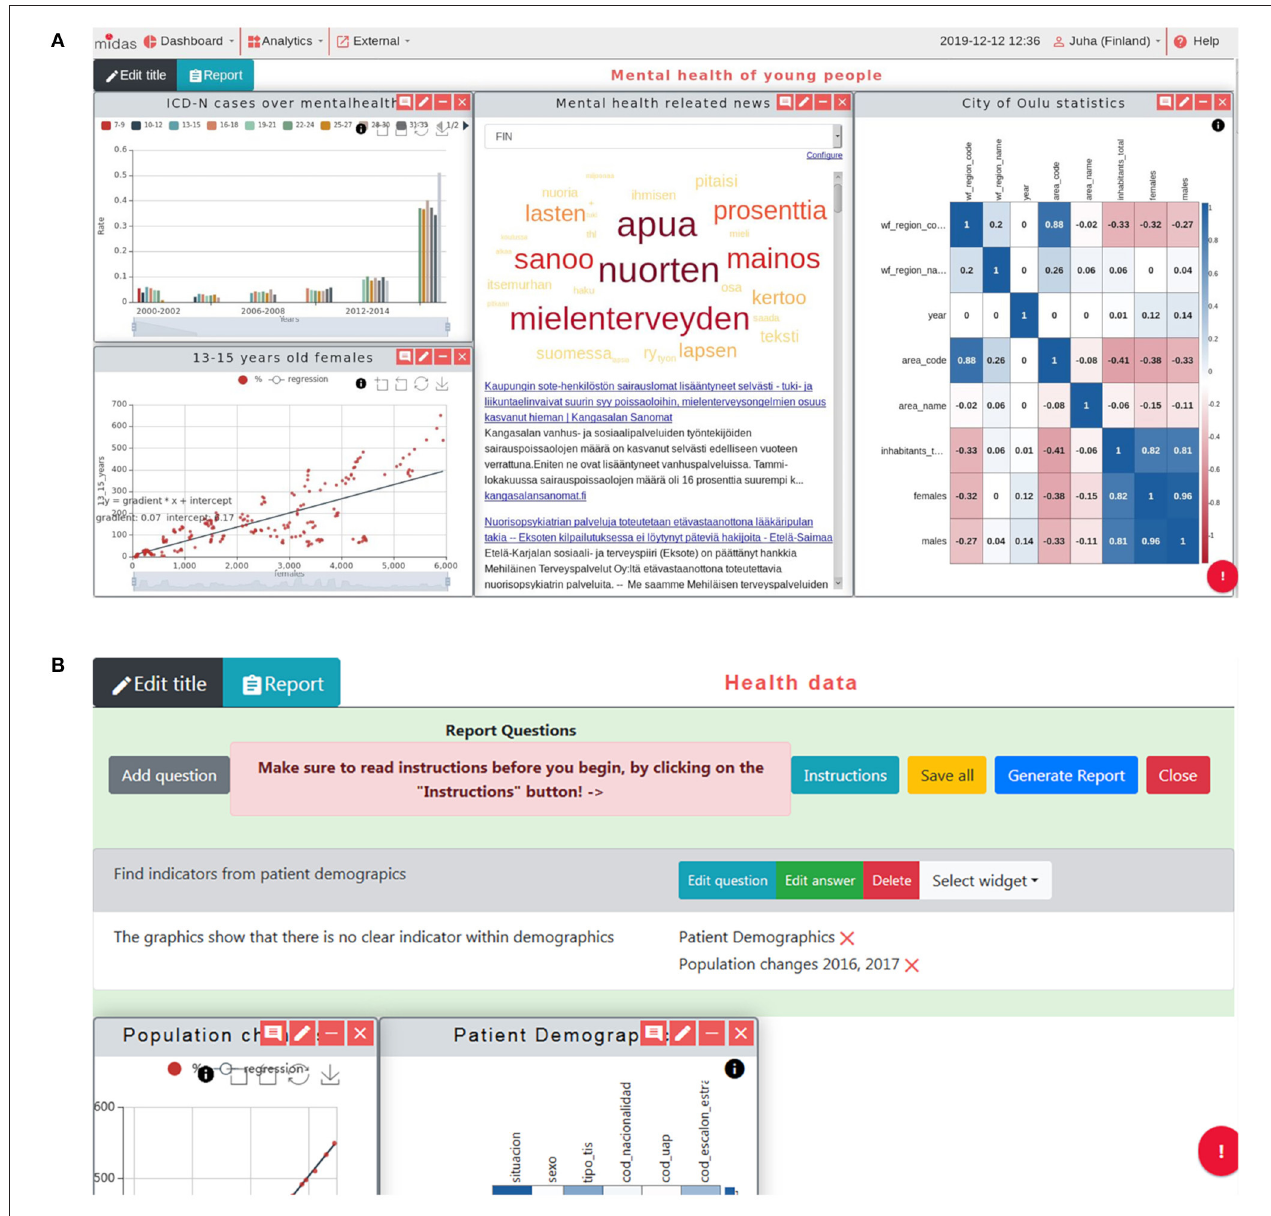
FIGURE 5 | MIDAS UI screenshots. (A) Common view of generated dashboard. On top of the view are the menus to manage dashboards, add analytics and use the external resources. The reporting tool is located in the middle (hidden in figure) and the rest of the view is the open space for widgets. Users can freely resize and organize widgets in this space. The analytic results come from the MIDAS Analytics Backend, together with the widgets developed externally. (B) Reporting tool open with a single research question and an answer with two associated widgets. This tool is used to generate a PDF file, defining the research questions and answers and attaching the most suitable figures describing them from the available widgets. © [2021] IEEE. Reprinted, with permission, from